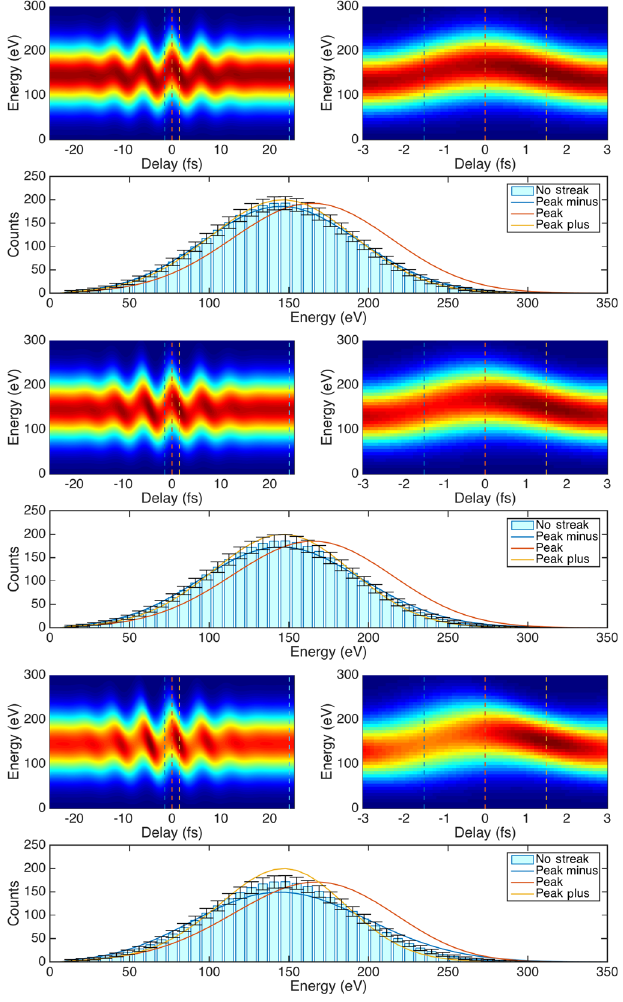
FIG. 10. Noise-free streaking field intensity simulations. Top: Low intensity; bottom: high intensity. Left: No attochirp simu- lated; right: 2500 as 2 simulated.